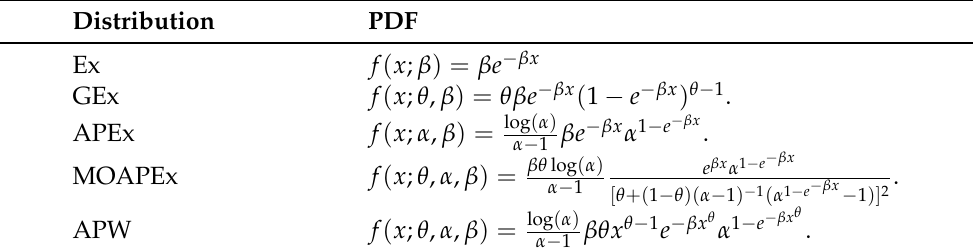
Table 7. The PDFs of different competitive